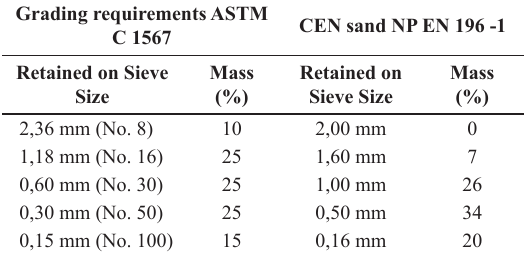
Figure 4. Slump-flow test.